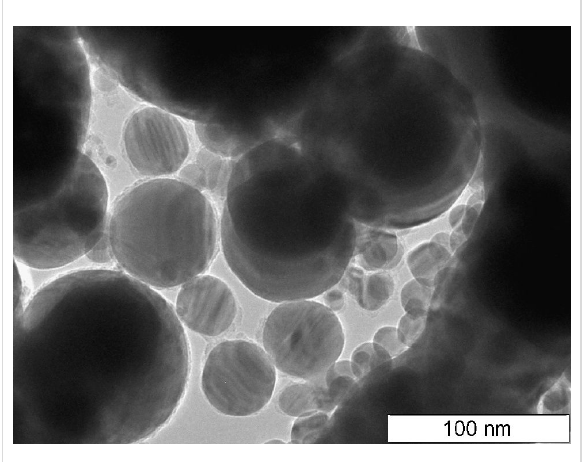
Figure 4: TEM micrograph of the Ag@Si nanoparticles along with Ag agglomerates.